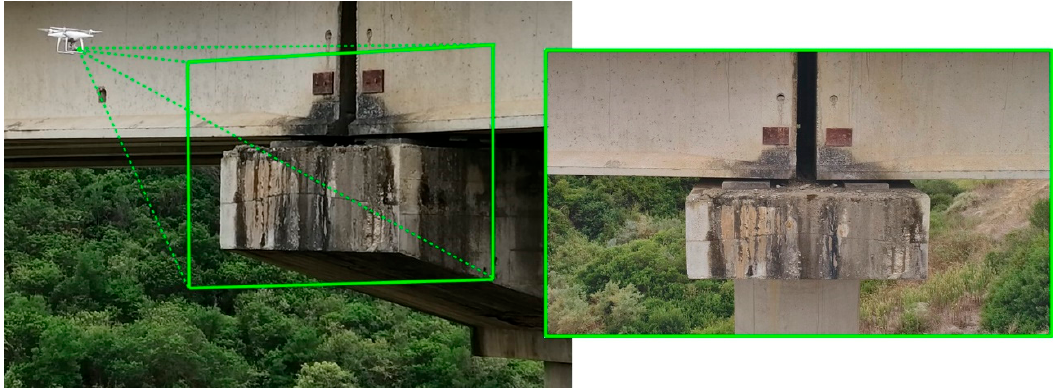
Figure 6. Visual inspection of the side of the structure by RPAS in manual mode.